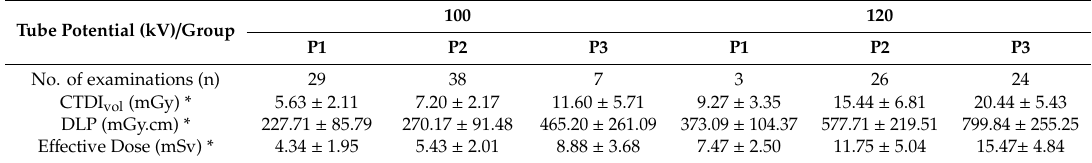
Table 3. Data on the scanning acquisition in CTPA examinations.